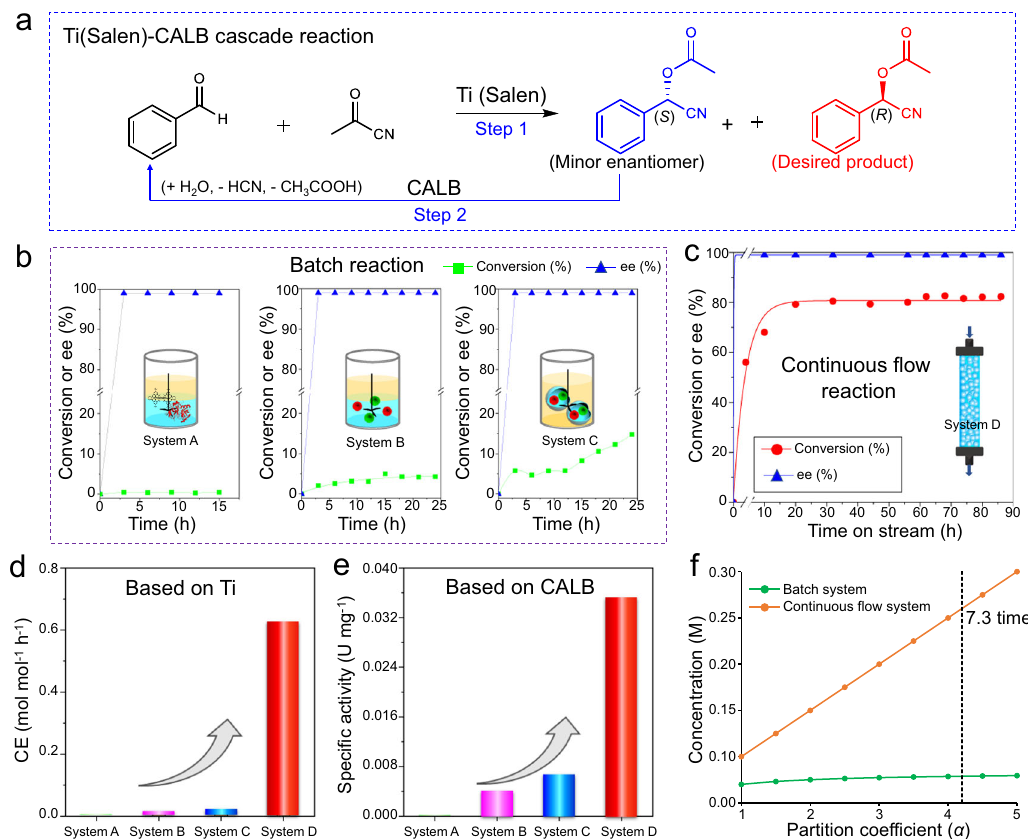
Fig. 3 Chemo-enzymatic cascade reactions in batch and fl ow systems. a Cascade reaction for the synthesis of chiral O-acylated cyanohydrin by cascading Ti(Salen) and CALB. b Kinetic pro fi les for different batch cascade reactions. System A: using Ti(Salen) and CALB as catalysts; System B: Ti/SCs and CALB/ SCs; System C: co-localization of Ti/SCs and CALB/SCs within a single microreactor (IL-in-oil emulsion). c Benzaldehyde conversion and e.e. of O-acylated cyanohydrin with time in the fl ow system with an IL-in-oil microreactor. d Catalysis ef fi ciency in the batch and fl ow reactions. e Speci fi c activity of CALB in different systems. For batch reactions, CE and speci fi c activity were calculated according to the conversion within the fi rst 10 h; for the fl ow reactions, CE was calculated after the conversion leveled off. f Calculated benzaldehyde concentration in IL as a function of the partition coef fi cient in the batch and fl ow systems. Batch reaction conditions: System A: 2.1 mL [BMIM]PF 6 , 3 mL PEG-300, 0.9 mL PBS (pH 7.4, 0.05 M), 0.08 g Ti(Salen), 0.03 g 4-dimethylaminopyridine (DMAP, as co-catalyst) 43 , 0.9 mL CALB (8.0 mg mL − 1 of protein), 3 mL n -octane containing benzaldehyde (0.05 M) and acetyl cyanide (0.2 M), 25 °C, 900 rpm; System B: using Ti/SCs and CALB/SCs;System C: Ti/SCs and CALB/SCs co-localized within a single microreactor. Flow reaction conditions: the system consists of 2.1 mL [BMIM]PF 6 , 3 mL PEG-300, 0.9 mL PBS (pH 7.4, 0.05 M), 0.2 g Ti/SCs, 0.1 g CALB/SCs, 3 mL n -octane, 0.18 g emulsi fi er. Benzaldehyde (0.05 M) and acetyl cyanide (0. 2 M) in n -octane as mobile phase, 25 °C, fl ow rate = 1 mL h − 1 . All the reactions were repeated twice to obtain an